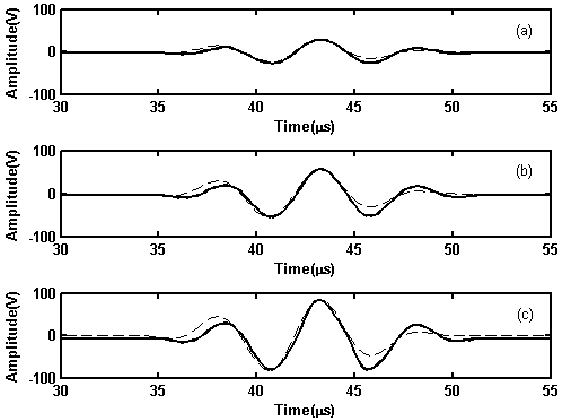
Figure 12. Output results of Hanning-window-function-modulated 180-kHz three-cycle sinusoidal signals with Vpp of ( a ) 56 V, ( b ) 112 V, ( c ) 163 V when the EMAT was used as the load. Solid lines are measured values, and dashed lines are ideal waveforms.